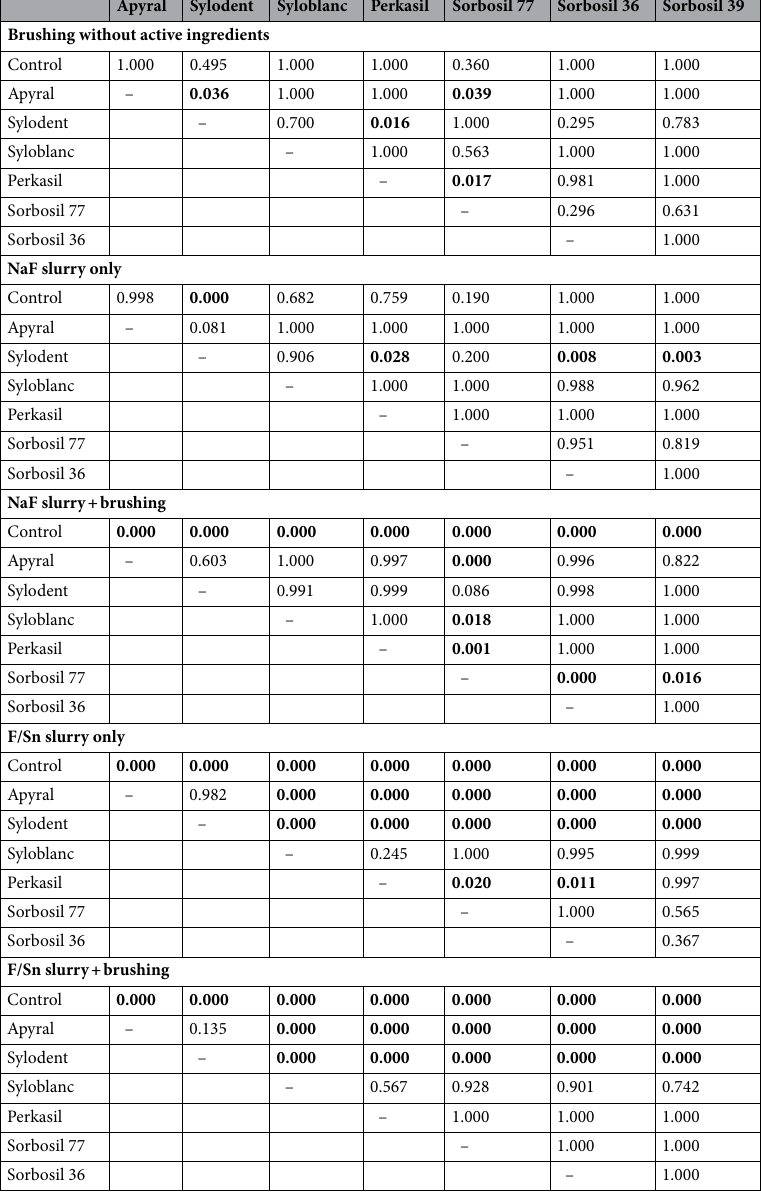
Table 2. Compilation of p values (ANOVA) for comparisons of the effects of the different particle types at T4; significant differences are marked in